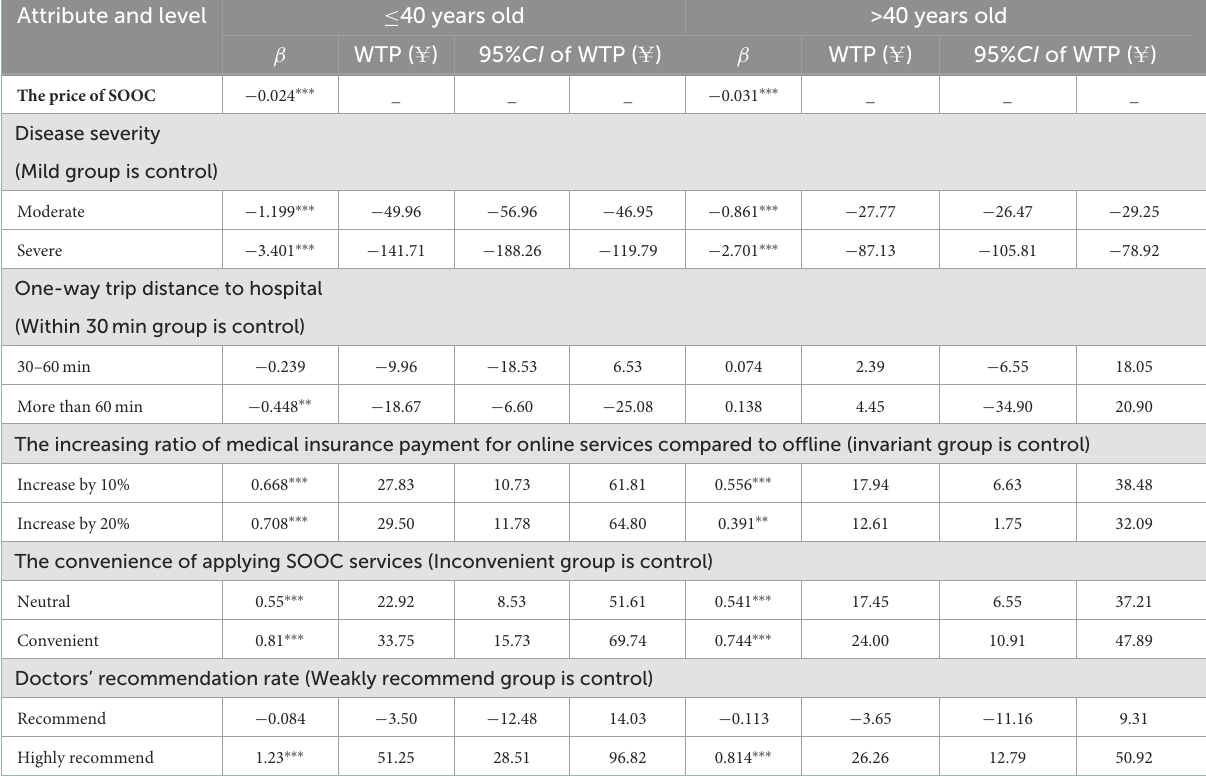
TABLE 6 Conditional logit regression analysis and the WTP for patients of different ages. Attribute and